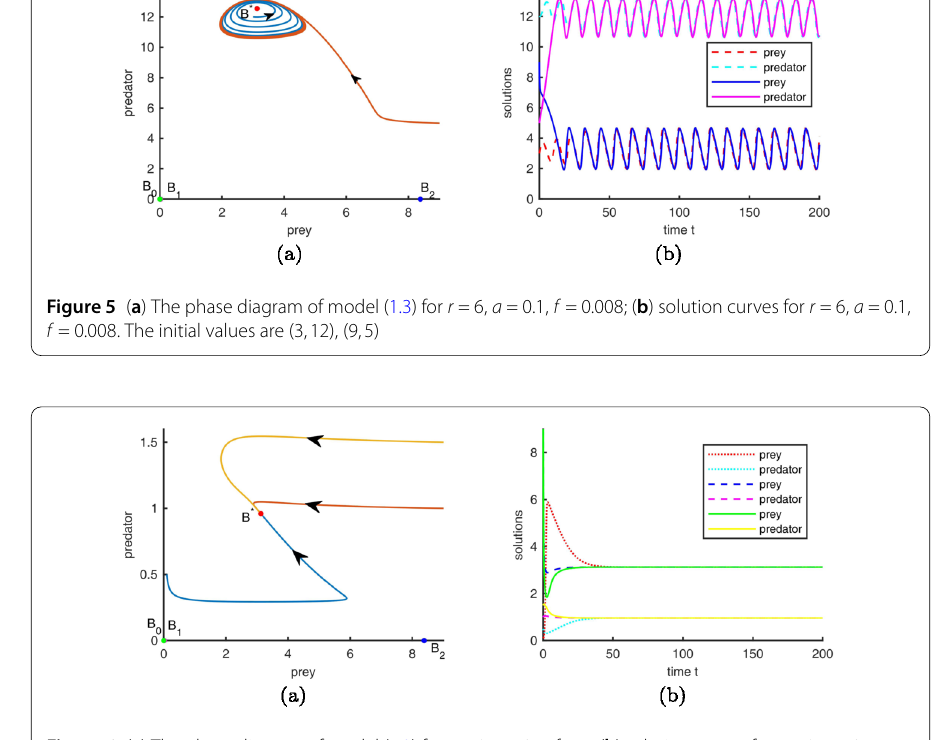
Figure 6 ( a ) The phase diagram of model (1.3) for r = 6, a = 0.1, f = 1; ( b ) solution curves for r = 6, a = 0.1, f = 1. The initial values are (0.1,0.5), (9,1),